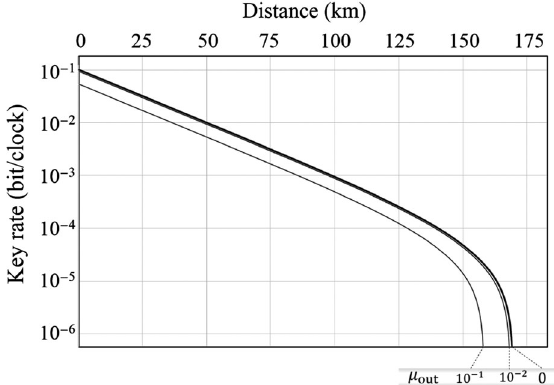
FIG. 8. Asymptotic key rate R (cid:4) versus distance for the single- photon efficient BB84 protocol, under a passive THA. The rate is plotted for various values of the parameter μ simulation are as in Fig. 3.